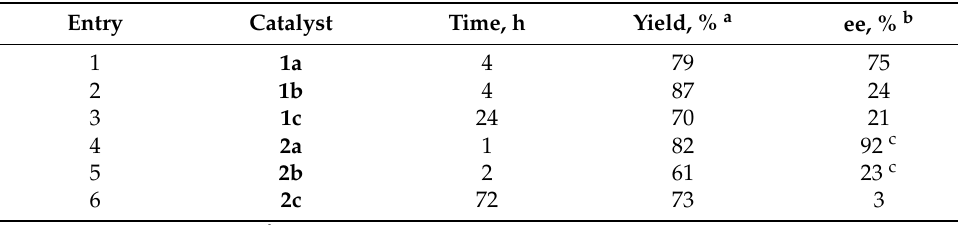
Table 2. Effect of the crown catalysts ( 1 or 2 ) in the epoxidation of chalcone ( 13 ). Entry